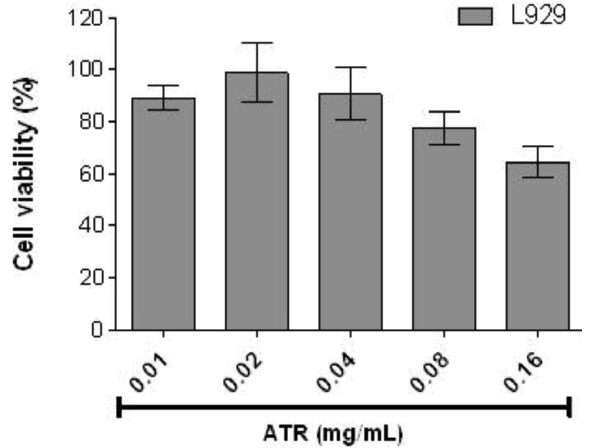
FIGURE 5 - Cytotoxic effect of atranorin (ATR) in L929 cell line. Each value represents the mean ± standard deviation (SD). ATR was dissolved in 12.5% dimethylformamide in the middle of the cell. The cytotoxicity of the solvent of these two cell lines and L929 (fibroblast) was evaluated. The concentration of 12.5% in the cells was not